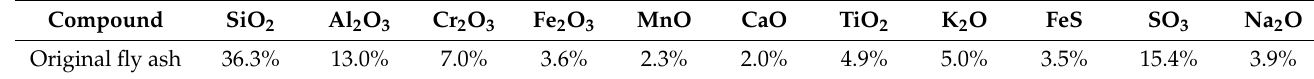
Table 1. Main Chemical Components of Fly